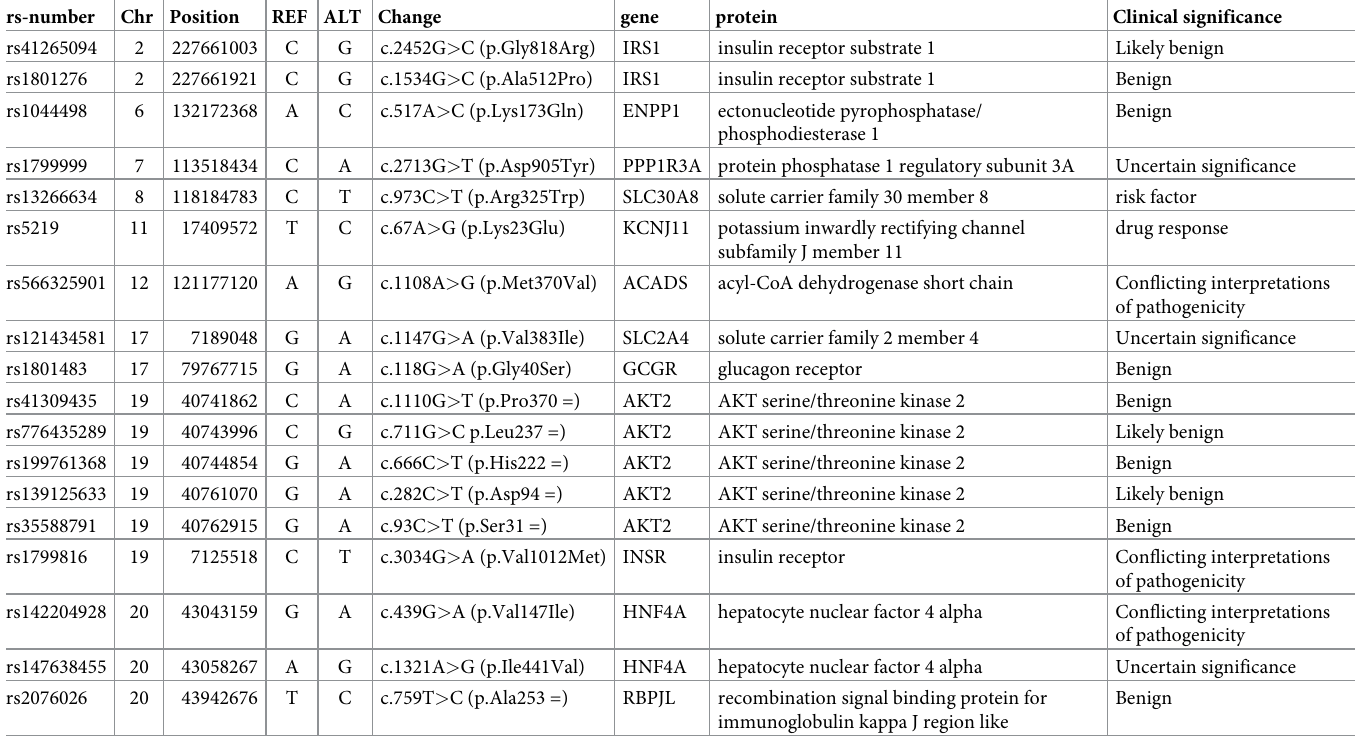
Table 1. List of T2D-related SNPs.